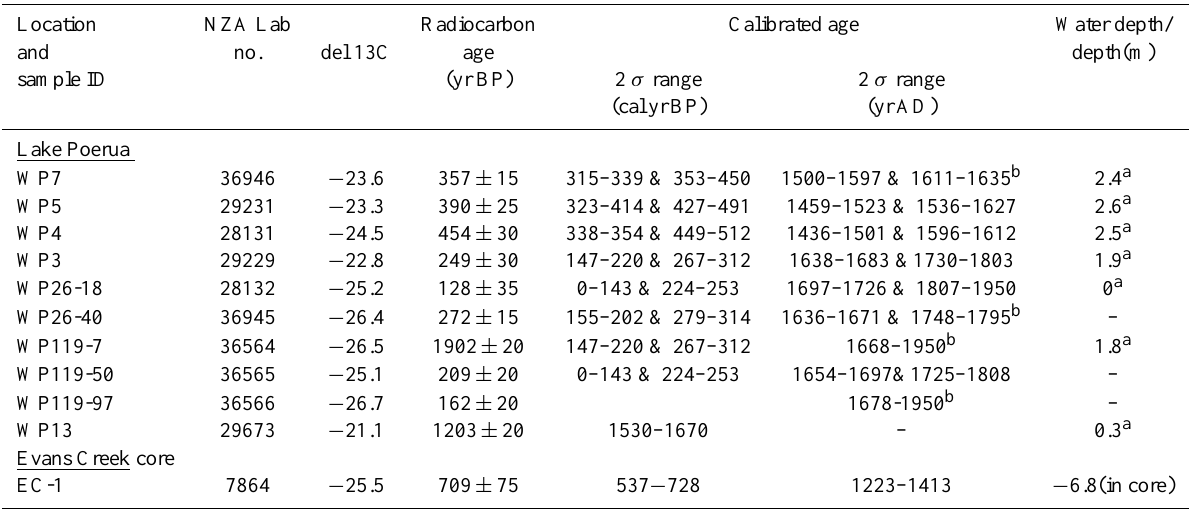
Table 1. Summary of radiocarbon dates from the Lake Poerua area.